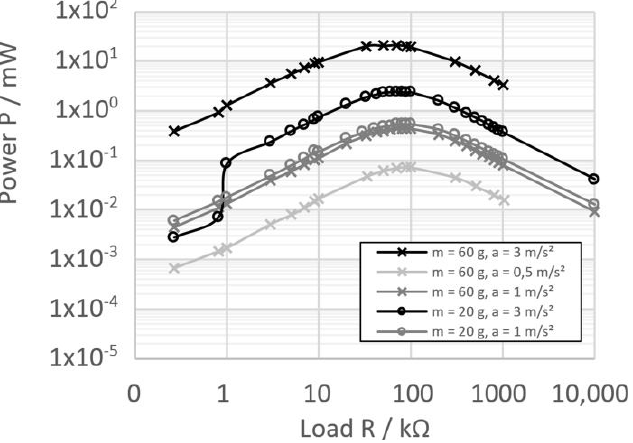
Figure 5. Electrical power of the piezoelectric VEH (one foil) at different natural frequencies and excitation amplitudes.